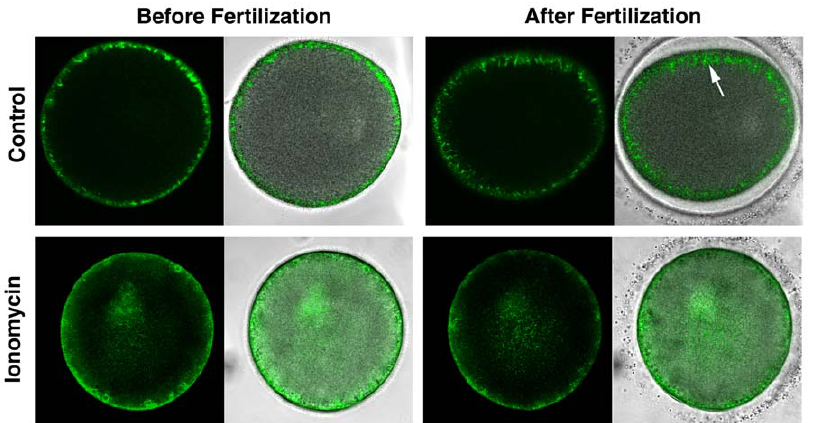
Figure 10. Ionomycin pretreatment disrupts the functionality of the cortical actin cytoskeleton. P. miniata oocytes were exposed to ionomycin (5 m M for 8 min) at the GV stage and subsequently incubated in fresh seawater containing 10 m M 1-MA. The mature eggs were then microinjected with Alexa Fluor 488-phalloidin and inseminated to monitor with confocal microscopy the real-time changes of the actin cytoskeleton. In the control eggs, the orderly arranged subplasmalemmal actin filaments migrated centripetally (arrow), which was synchronized with the elevation of the fertilization envelope. In contrast, mature eggs previously exposed to 5 m M at the GV stage failed to show such migration. At the right side of each panel, the fluorescence image of F-actin in confocal microscopy was merged with the transmission view of the same specimen. Images of the eggs before and after fertilization (13 min post-insemination) were taken from the same individual eggs.